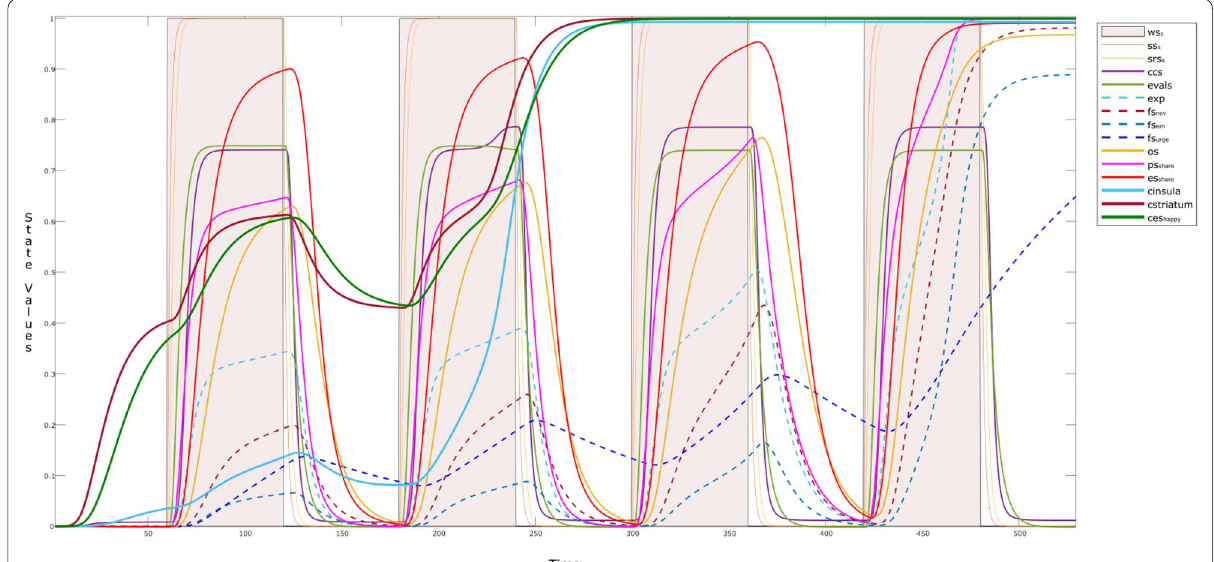
Fig. 4 Episodes showing the behavior of the child while a not using social media, and b while using social media, with the tendency of the exhibition of parental